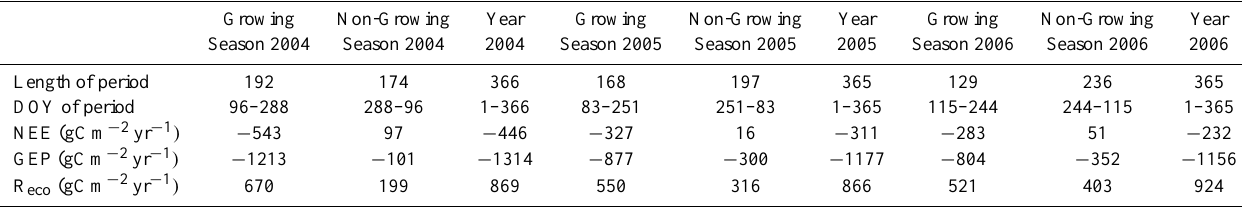
Table 5. NEE, GEP and R eco for growing seasons, non-growing seasons and whole years over 2004, 2005 and 2006.